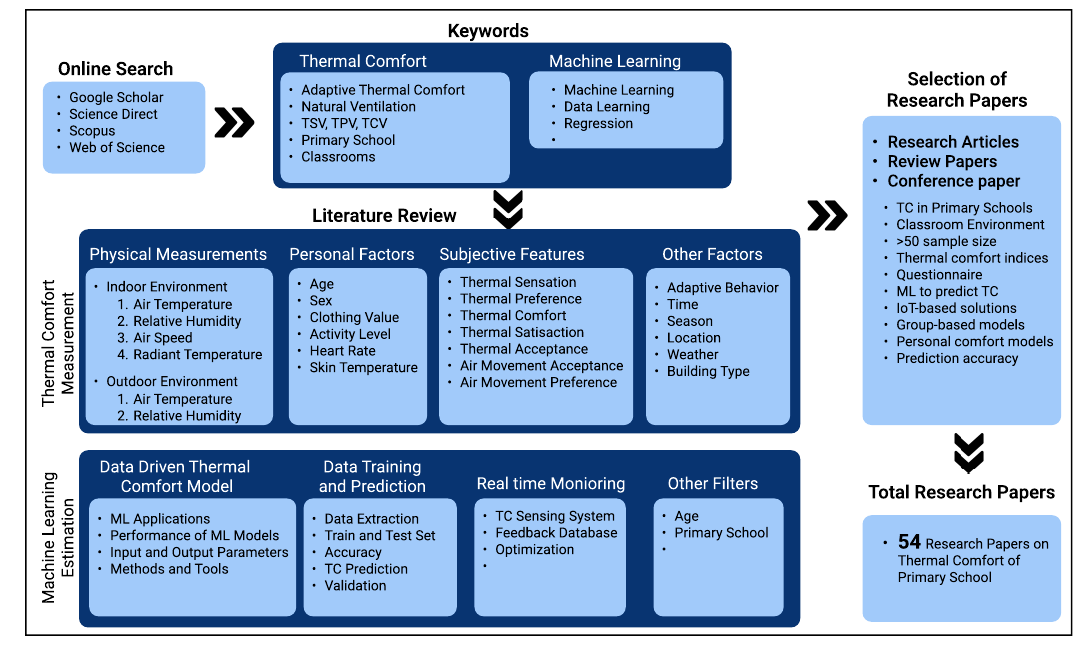
Figure 2. Research paper selection process.